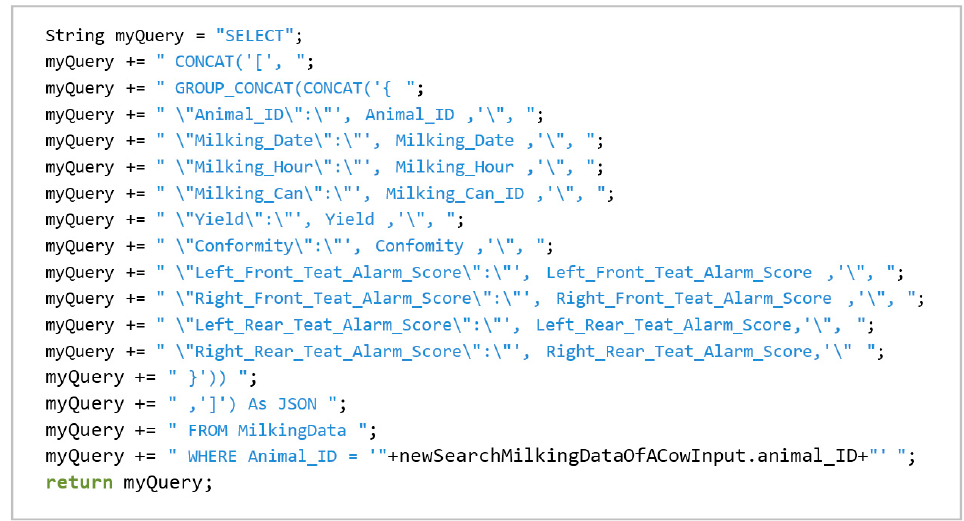
Figure 15. Example of a Groovy script (“queryMilkingDataOfACow”) used to retrieve milking data of a specific cow. The script builds a query using the “Animal_ID” provided by the user through the instantiation form “retrieveMilkingDataOfACow”. This completes the configuration of the database connector used by the business processes engine to retrieve the required data.